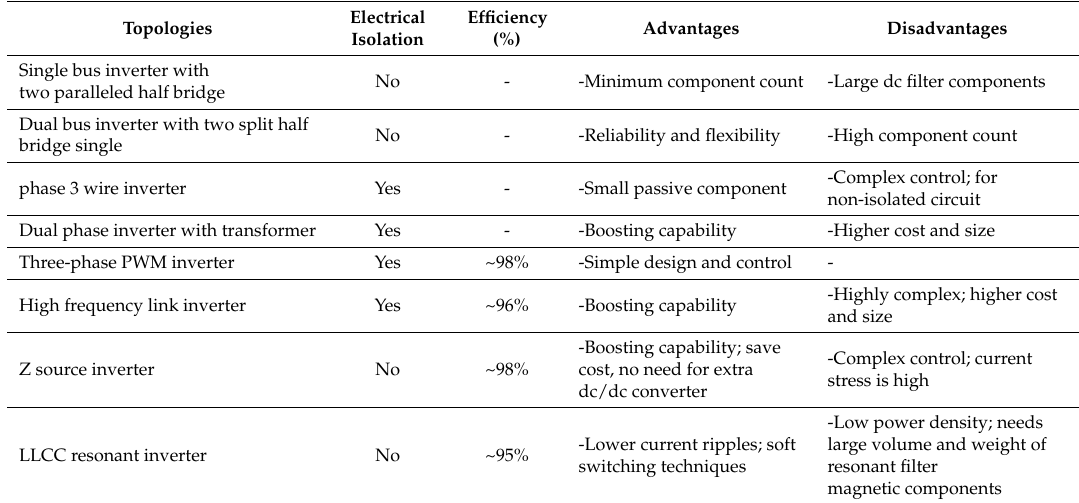
Table 6. Comparison of different DC–AC power inverter